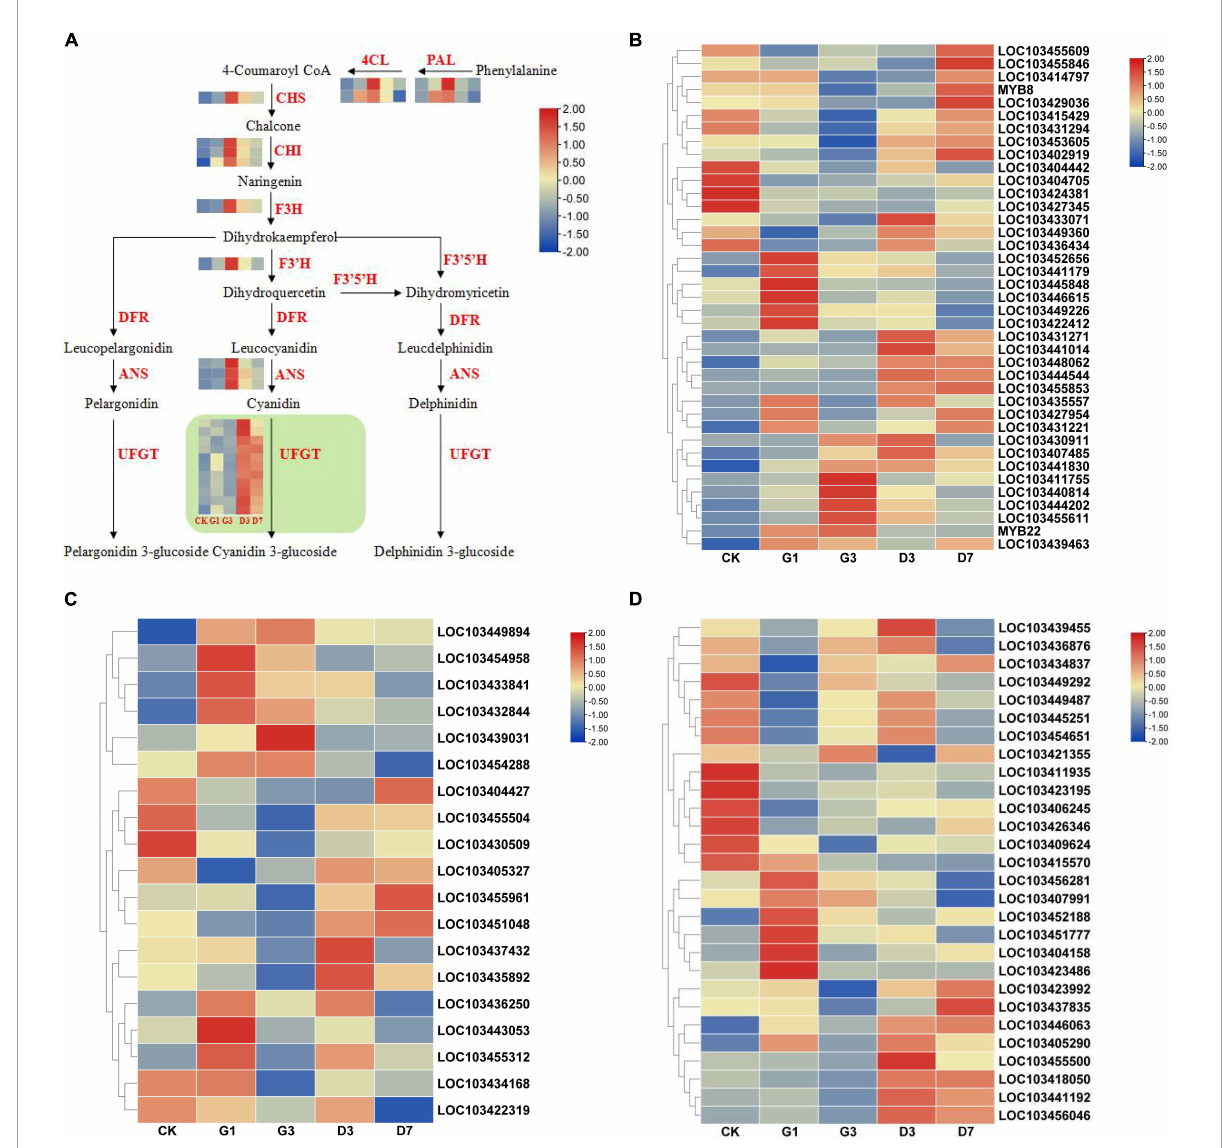
FIGURE8 Expression analysis of the structural genes in anthocyanin synthesis pathways and transcription factors in the peel of different treatments. (A) Expression analysis of structural genes in the anthocyanin synthesis pathways in the peel under different treatments. Expression analysis of MYB (B) , bHLH (C) , and NAC (D) transcription